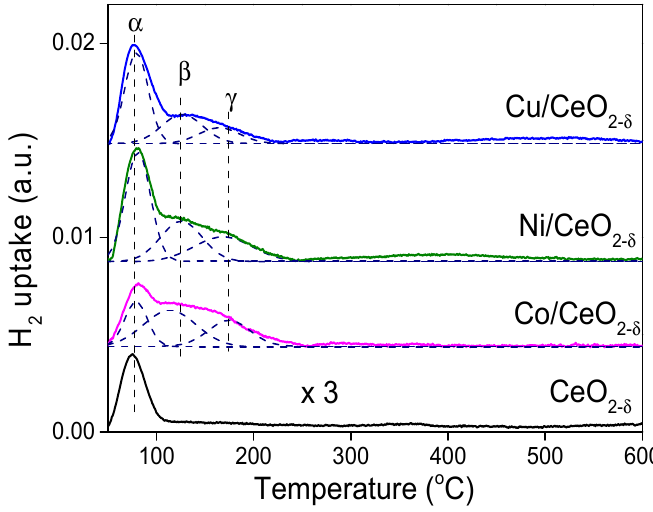
Figure 6. H 2 temperature programmed desorption (TPD) profiles of CeO 2 − δ and M/CeO 2 − δ catalysts. Table 2. H 2 uptake, metal dispersion and hydrogenation rate constants on the M/CeO 2 − δ catalyst. Sample